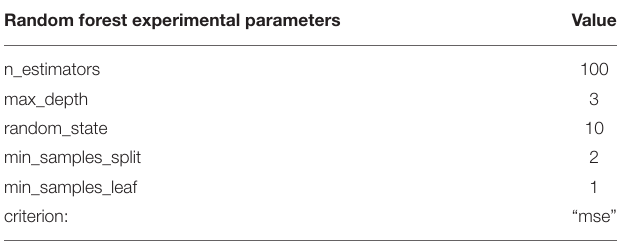
TABLE 5 | Random forest parameter